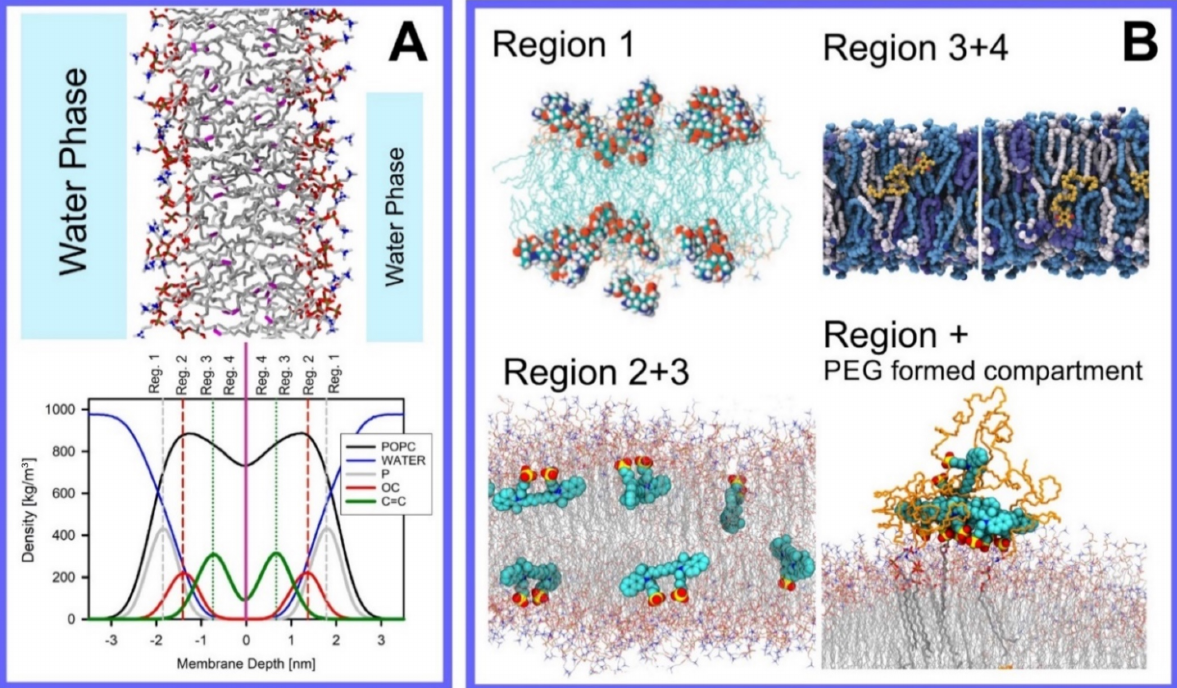
Figure 7. Location of the drugs and small molecules in four regions of a lipid bilayer. ( A ) Top panel: Snapshot of lipid bilayer composed of POPC; Lower panel: corresponding density profiles showing location of lipids, water, phosphate atoms, carbonyl atom (C35), and atoms of double bond of oleoyl chain (C9=C10) of POPC (see Figure 1). Data from 1000 ns simulation of hydrated POPC bilayer with our OPLSaa lipid force field [141–143]. ( B ) Snapshots showing location of small molecules in different regions of the bilayer: kanamycin A locates to region 1 (reproduced with permission from [133]), indocyanine green locates to region 2 and 4, and entangled in PEG corona (reproduced with permission from [144]), ubiquinone locates to region 3 and 4 (reproduced with permission from